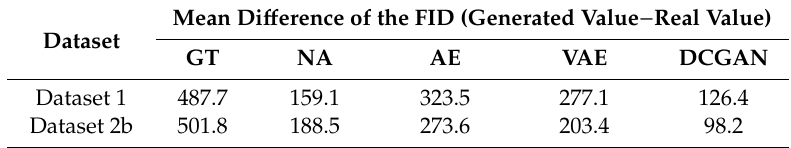
Table 5. Results for the di ff erence Fre é chet inception distances